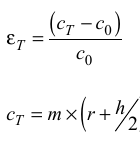
flat, c completely 0 T